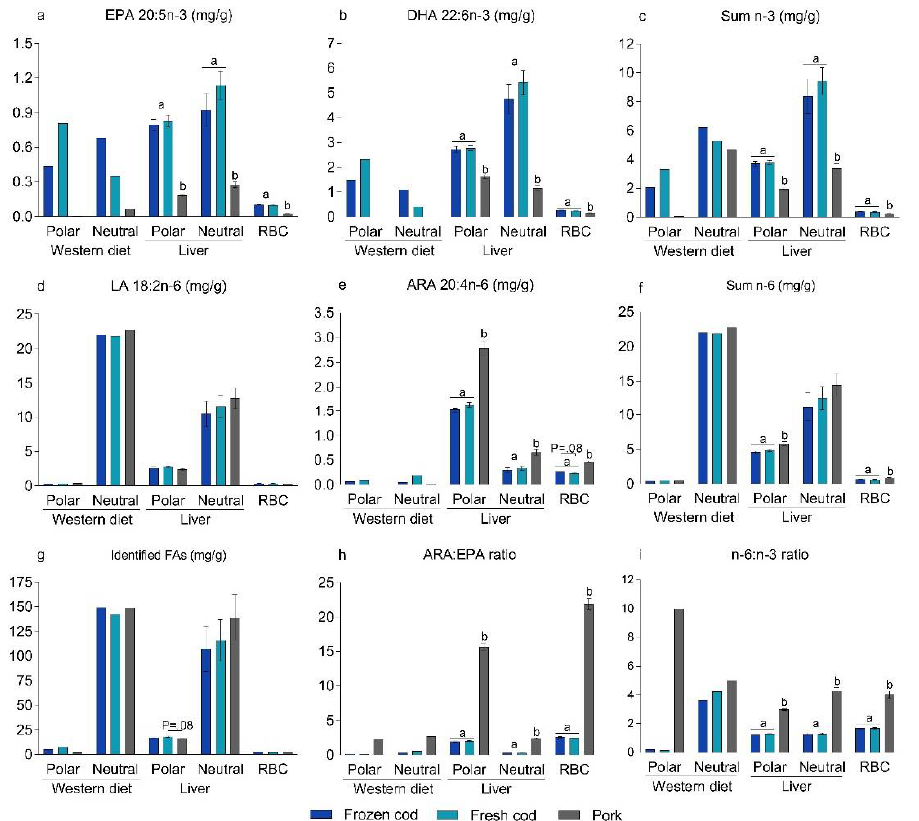
Figure 2. Fatty acid (FA) composition in polar and neutral lipid fractions in Western diets based on frozen cod, fresh cod, and pork as protein sources, and in mouse livers and red blood cells (RBCs) following intake of the different diets. Data from the Western diets represent the means of three samples, and data from the livers and RBCs represent means ± SEMs ( n = 10). Results indicate mg FAs in the polar and neutral lipid fractions/g Western diet and livers, and mg FAs/g RBCs. Lipids from Western diets and livers were extracted and separated into polar and neutral lipid fractions. The FA compositions of the fractions from the Western diets and livers as well as the FA compositions of extracted lipids from RBC were quantification and determined; ( a ) eicosapentaenoic acid (EPA); ( b ) docosahexaenoic acid (DHA); ( c ) sum n -3; ( d ) linoleic acid (LA); ( e ) arachidonic acid (ARA); ( f ) sum n -6; ( g ) identified fatty acids (FAs); ( h ) arachidonic acid: eicosapentaenoic acid ratio (ARA:EPA); ( i ) n -6: n -3 ratio. Data from livers and RBCs were analyzed using one-way ANOVA followed by Fisher’s LSD post hoc tests. Different letters denote statistical significance ( p ≤ 0.05) between the groups.